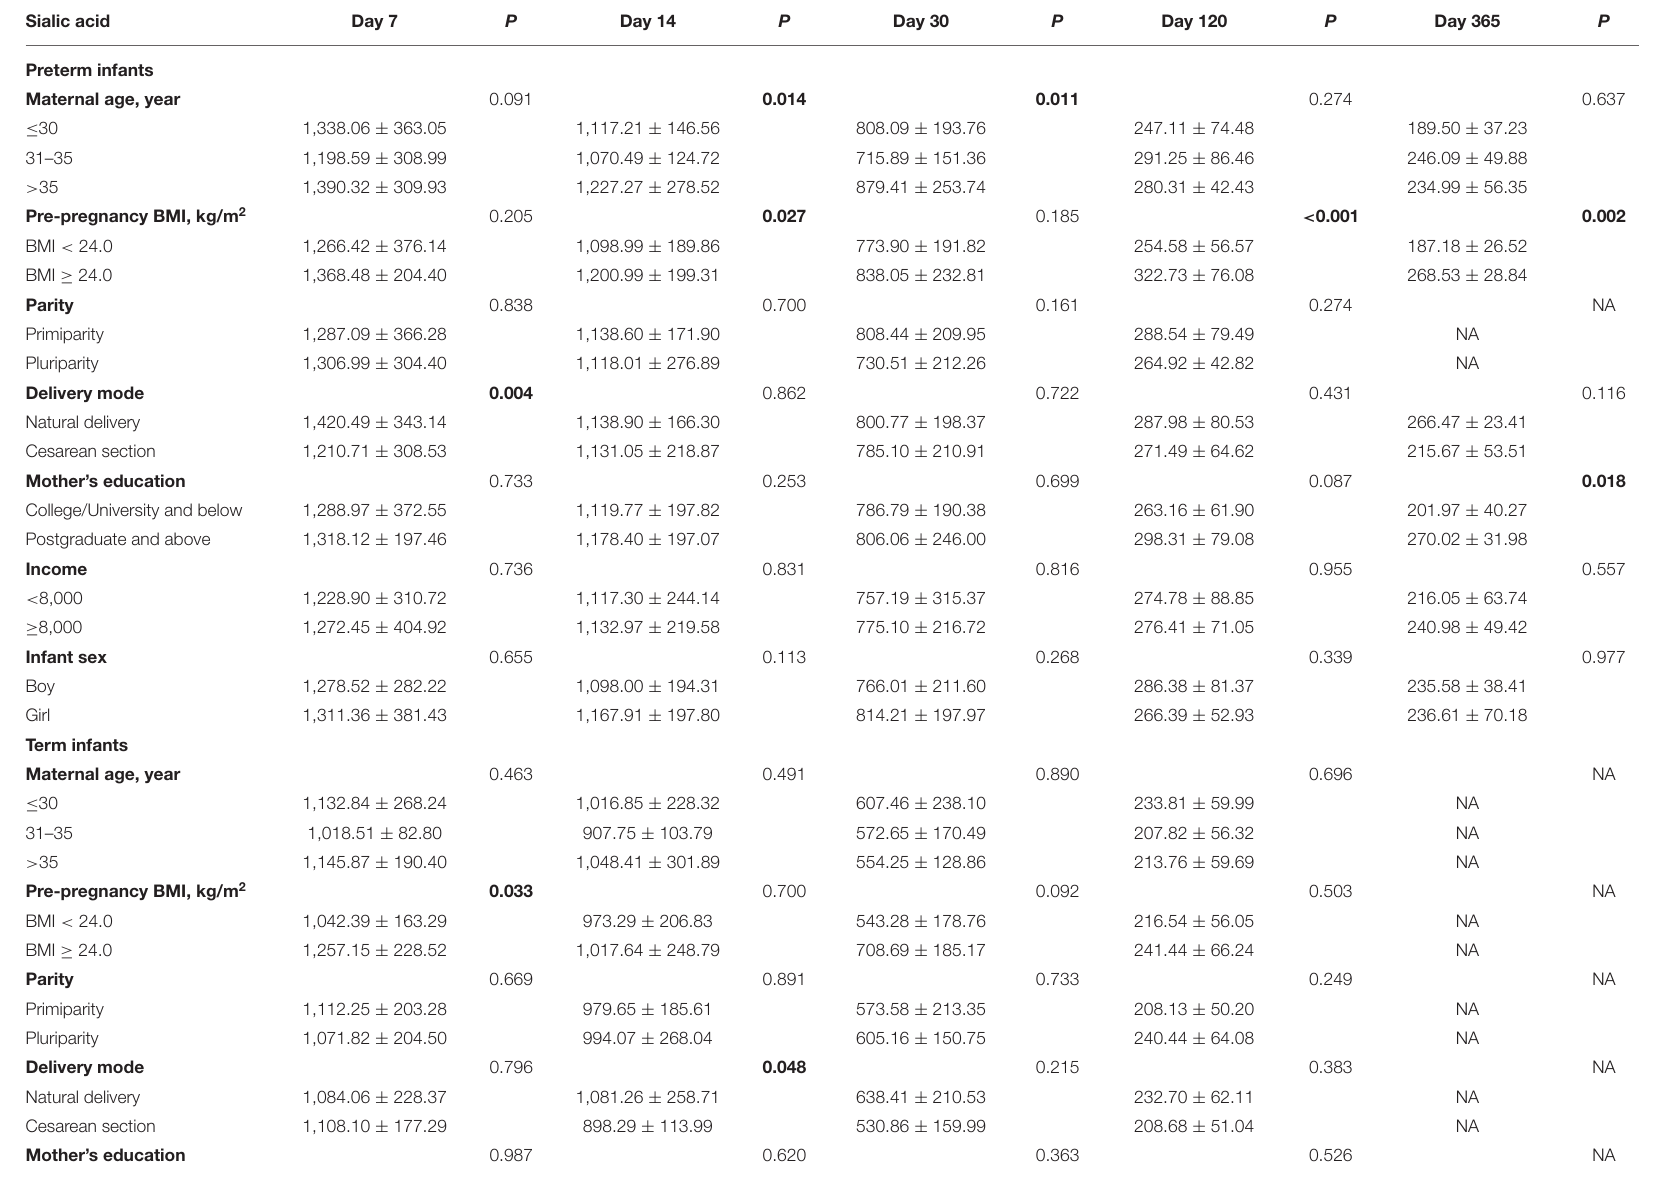
TABLE 2 | Distribution of sialic acid contents in breast milk under different variables (mg/L, Mean ± SD). Sialic